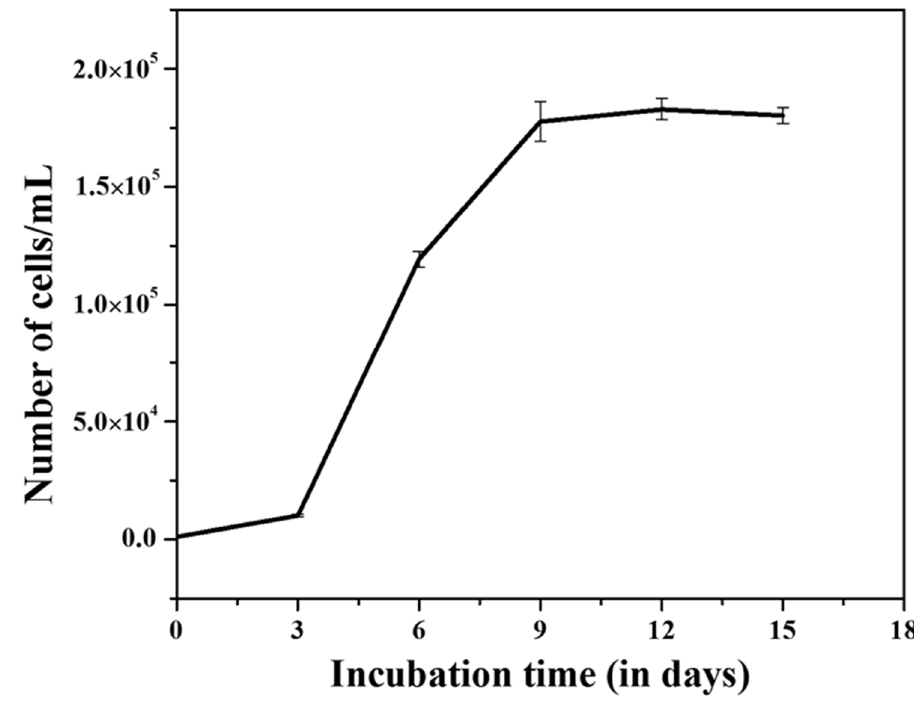
Figure 1. Growth response of T. lundiana CSIRCSMCRI 001 in modified f/2 media under laboratory conditions.